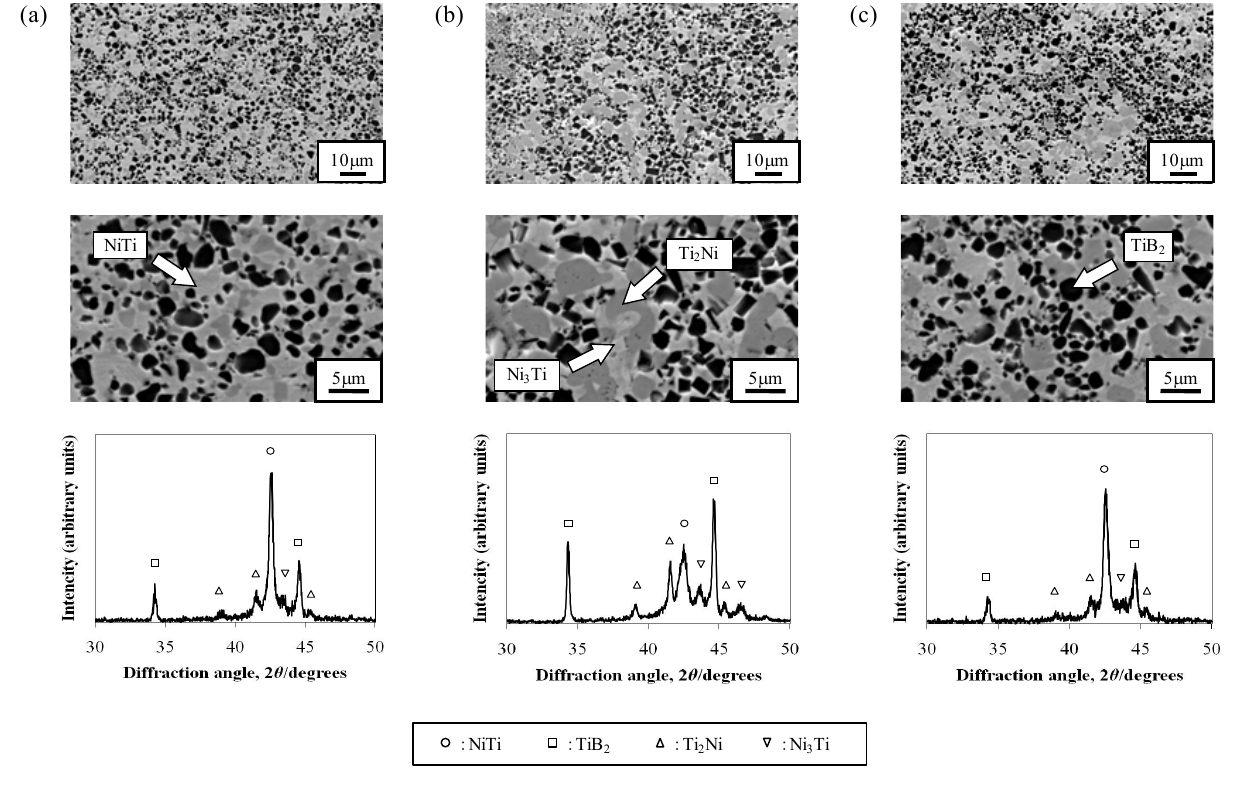
Figure 5. Micro structure and XRD spectra of combustion synthesized samples. ( a ) Ni powder denomination: fine, and Ti powder denomination: fine; ( b ) Ni powder denomination: coarse, and Ti powder denomination: fine; ( c ) Ni powder denomination: fine, and Ti powder denomination: